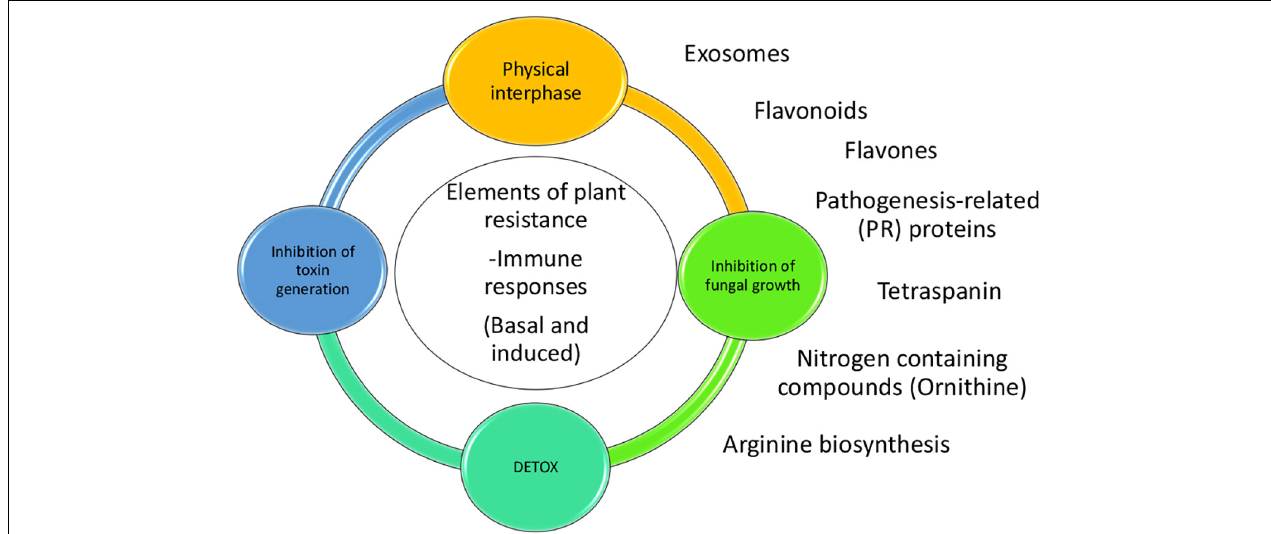
FIGURE 5 | Model of the proposed plant responses to aflatoxin contamination. There are several elements of resistance to aflatoxin contamination such as events taking place in the physical interphase between fungi and kernel, inhibition of fungal growth, inhibition of toxin generation and detoxification. Some of the pathways and proteins tare are linked to the resistance to contamination are production of vesicles/exosomes, pathogenesis related proteins, tetraspanins, N-containing compounds (Ornithine), arginine biosynthesis and flavones/flavonoids. Flavonoids and flavones could be working in-between the physical interphase and the inhibition of fungal growth.